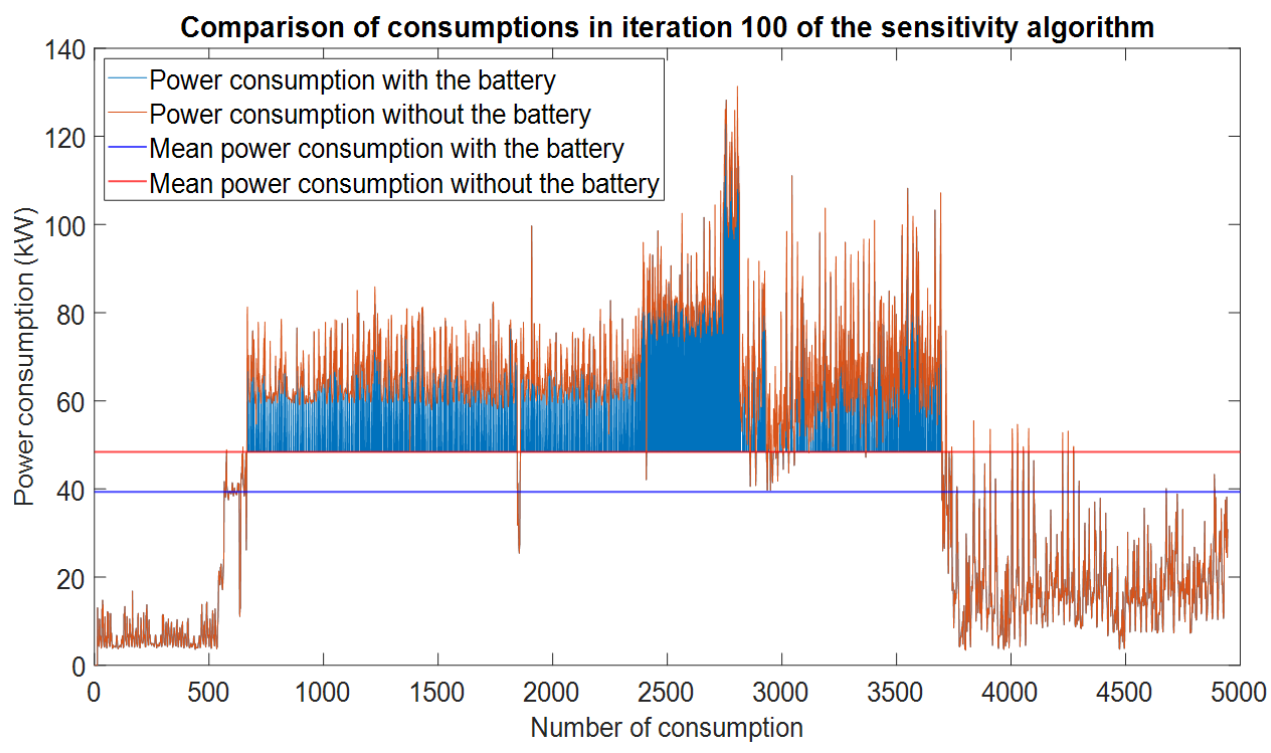
Figure 12. Power consumption (kW) comparison with and without the battery (iteration